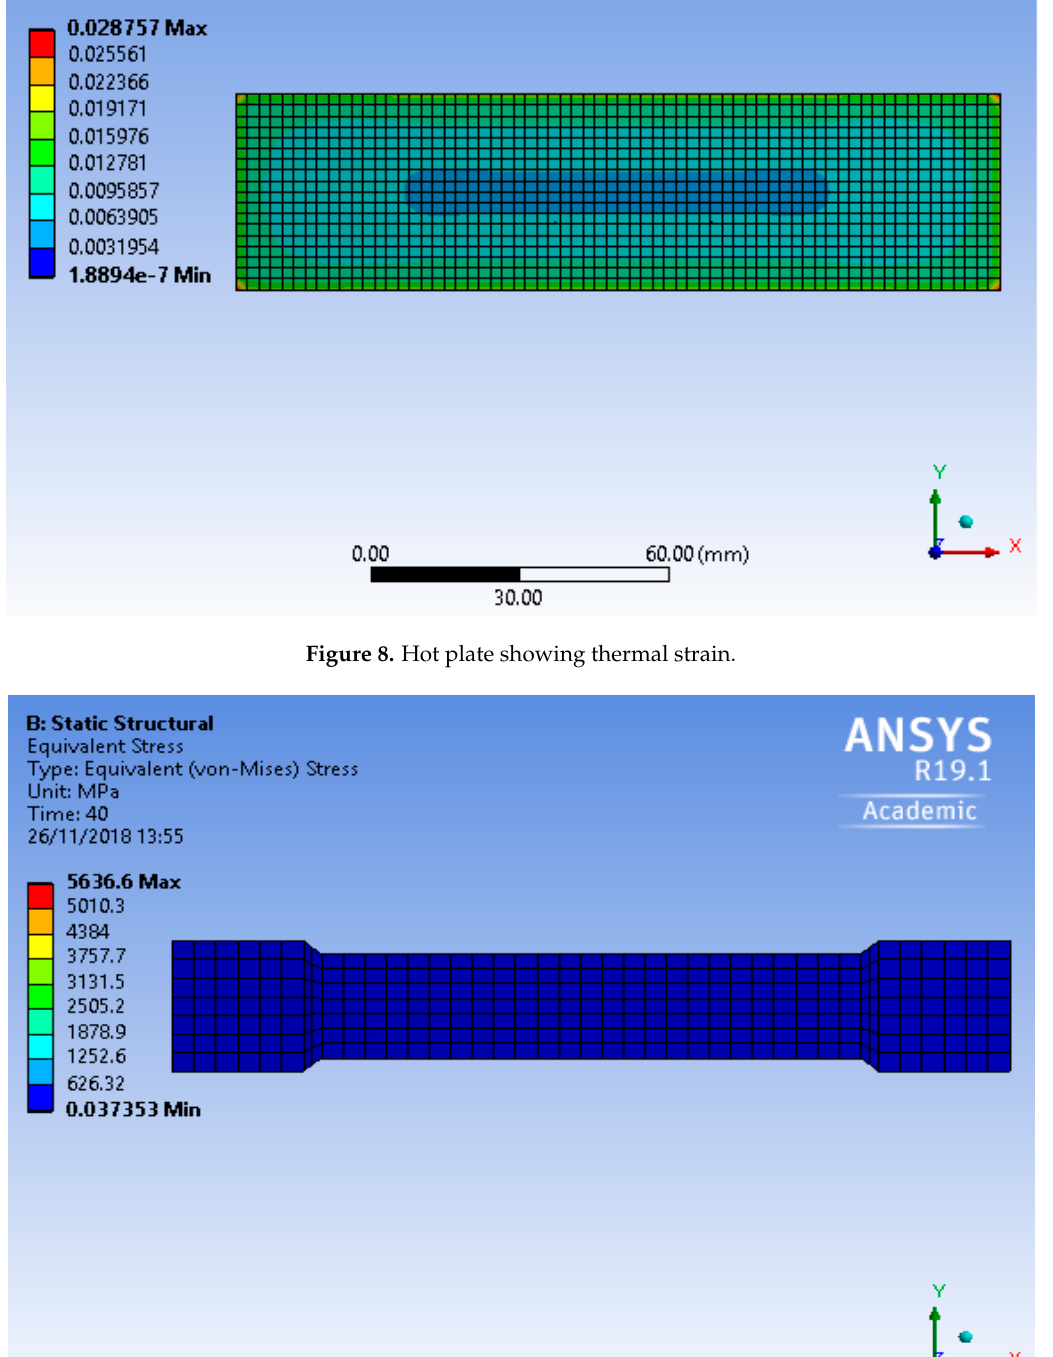
Figure 9. Thermal stress on the foil adjacent to the hot plate.